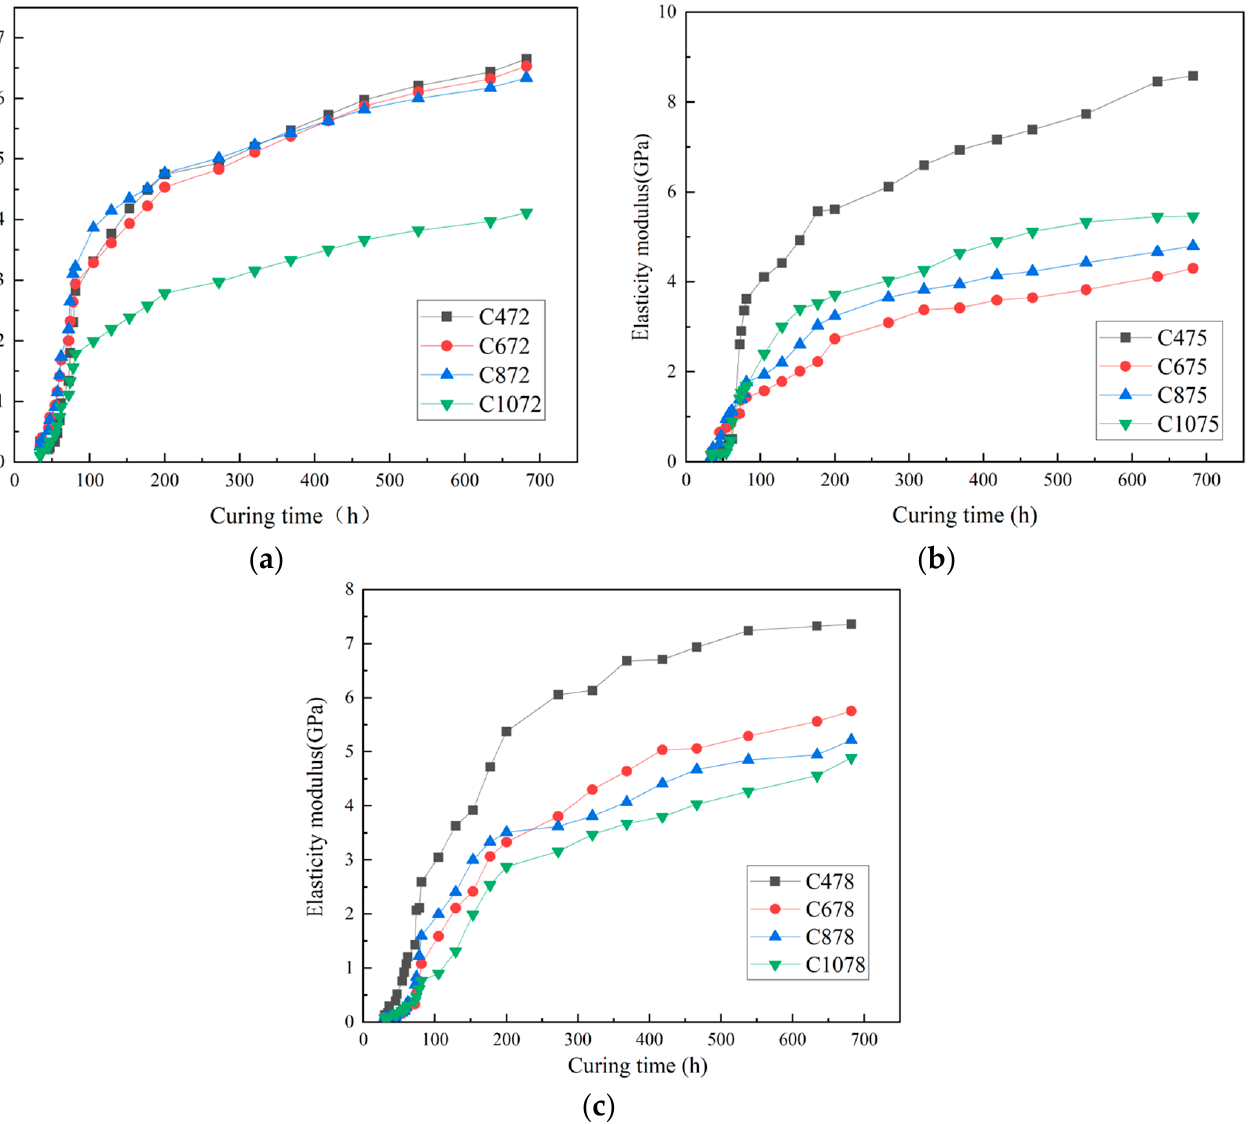
Figure 6. Development of DEM of CTB samples: ( a ) DEM, solid content of 72%; ( b ) DEM, solid content of 75% ( c ) DEM ,solid content of 78%.